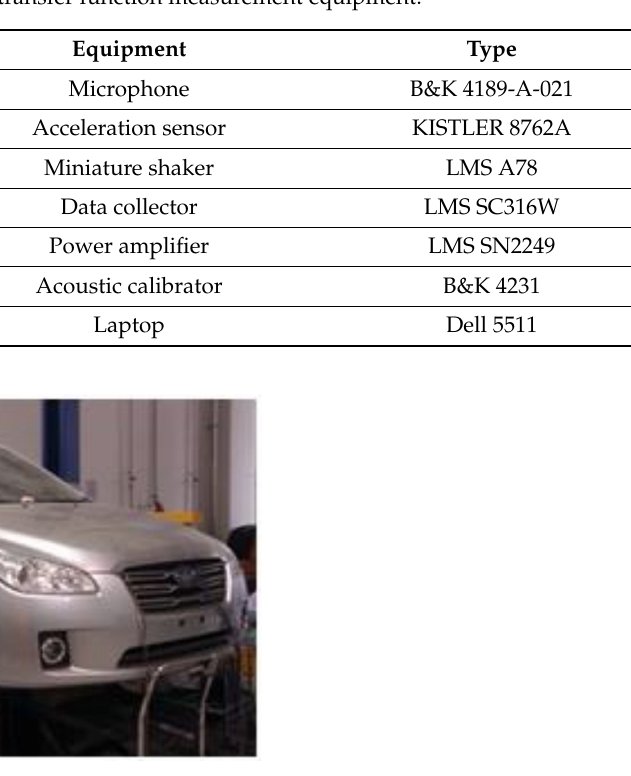
Figure 8. State of the whole vehicle when measuring the structure-borne noise transfer function.